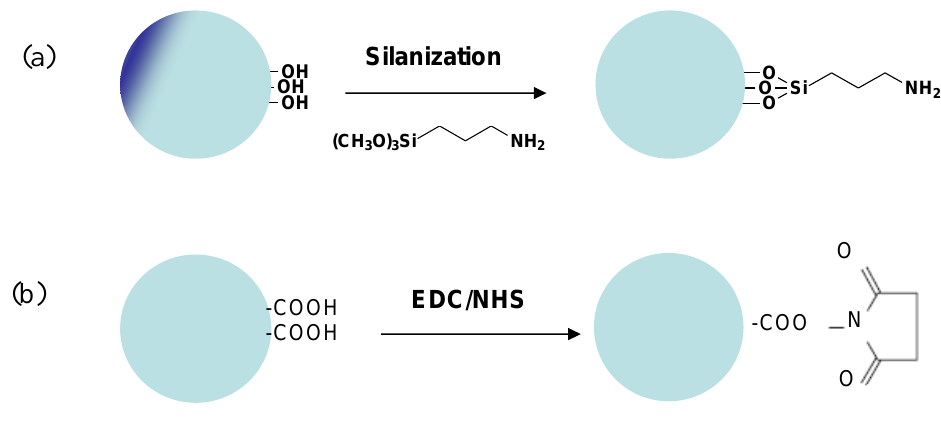
Figure 4. Functionalization of a WGM sensor: (a) a silane agent is used. In this case, the microsphere surface is previously functionalized with primary amine groups. In a second step, the receptors can be covalently bound to these groups; (b) after functionalization with Eudragit® the carboxyl groups (COOH) are activated with EDC/NHS